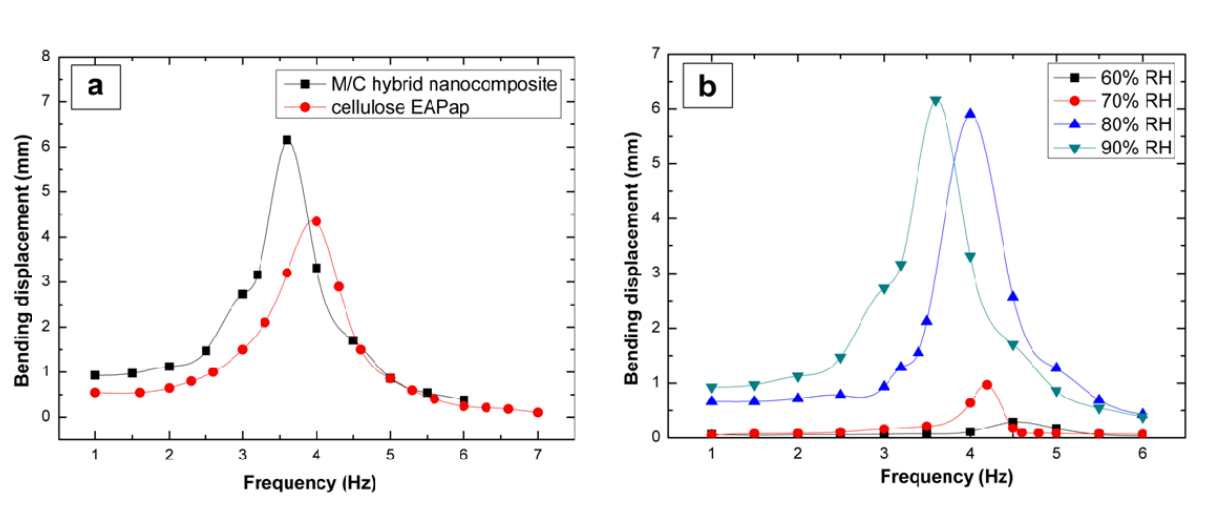
Figure 5. Actuator performance of M/C hybrid nanocomposite: a) compared with cellulose EAPap and b) depending on humidity level (Thickness (µm)/Young’s modulus (GPa): 16/6.0 (60% RH), 19/3.2 (70% RH), 21/2.9 (80% RH), 22/2.4 (90%